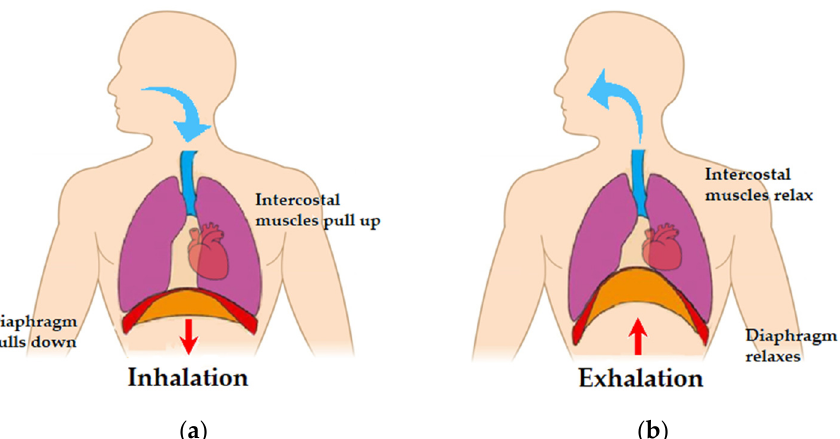
Figure 1. Heart, lungs, and diaphragm during: ( a ) inhalation; ( b ) exhalation. Illustration based on magnetic resonance imaging (MRI) of natural chest movement [13].